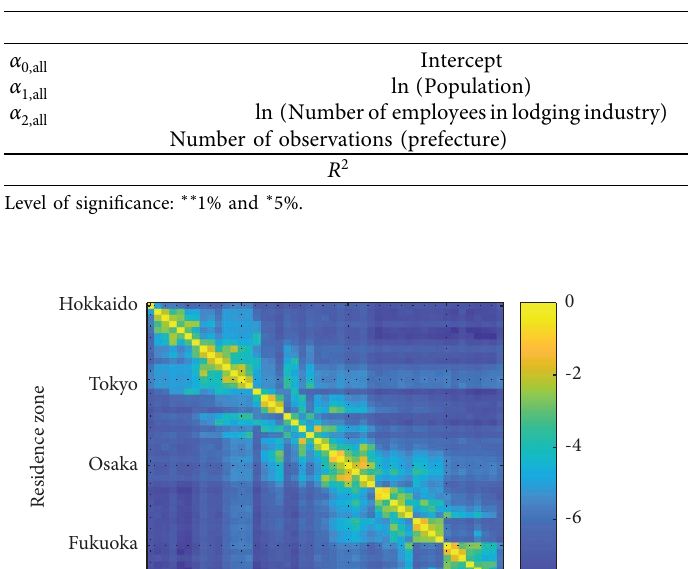
Table 2: Te regression analysis result of the destination amenity.